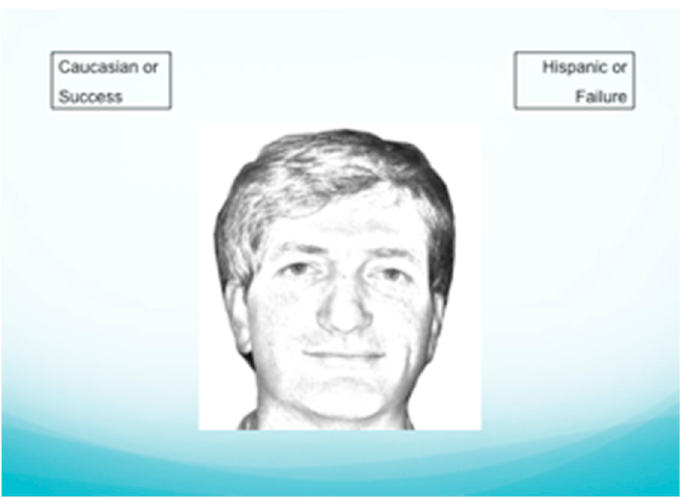
Figure A2. Sample screen from the IAT with a picture as the stimulus.